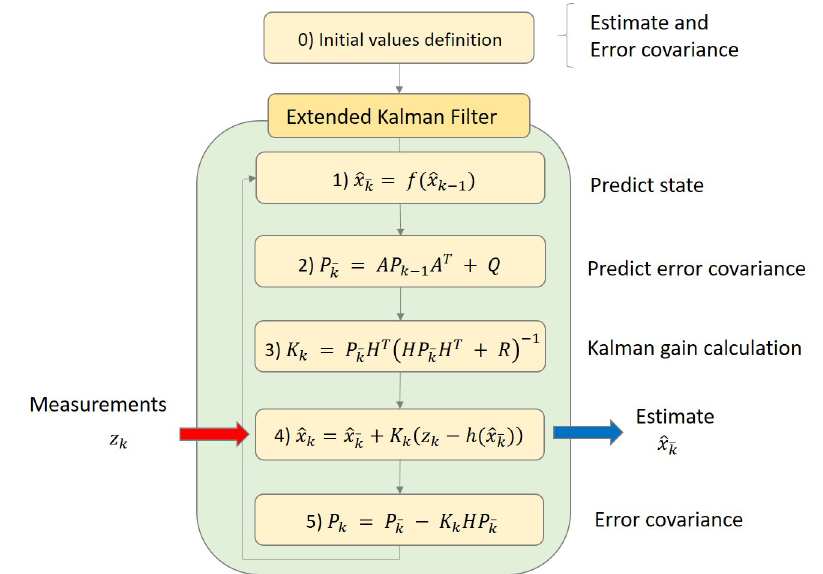
Figure 21. Schematic representation of the extended Kalman filter